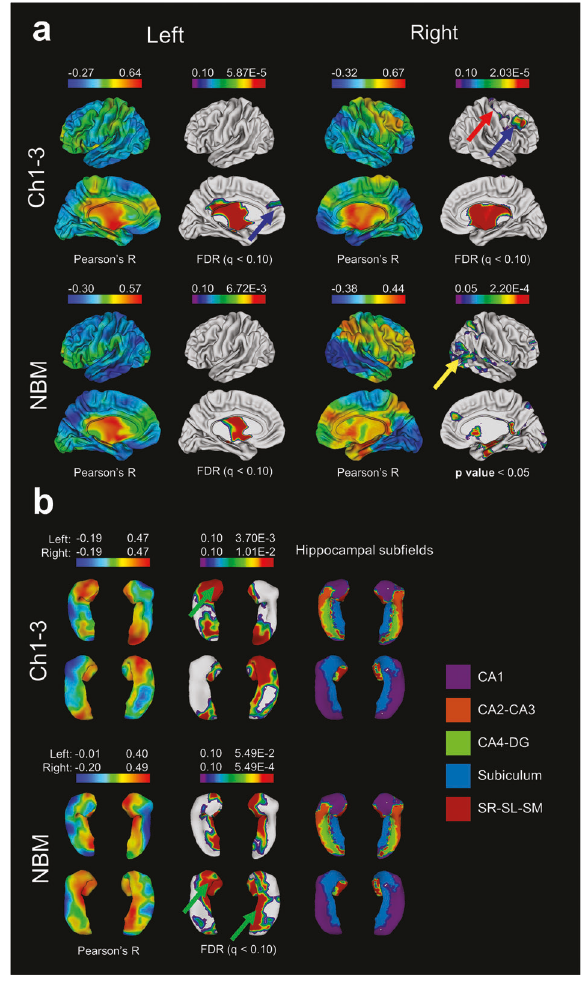
Fig. 3 NBM-cortical and NBM-hippocampal qT1 correlations. Warm colours (red) indicate most positive correlations, and cool colours (blue) negative correlations for each set of surfaces. Regions surviving FDR correction are displayed, while for the right NBM- cortical correlations no regions survived FDR correction at q < 0.10, and thus subthreshold fi ndings at p < 0.05 are shown instead. a NBM-cortical qT1 correlations. Findings are consistent with the hypothesis with strongest (most positive) correlations re fl ecting cortical regions receiving the most consistent afferent projections the BF, and those regions with cortical cholinergic neurons. These include the frontal (blue arrow), sensory/motor cortices (yellow arrow). b NBM-hippocampal qT1 correlations — for the hippocam- pus, CA1-subiculum demonstrate strongest correlations (green cortical surfaces show signi fi cant correlations, re fl ecting the medial pathway of Ch4 projections [72]. After FDR correction, we observed signi fi cant correlations for frontal (Fig. 3a, blue arrow), precentral/postcentral (red arrow). BF-hippocampal corre- lations show the CA1 and subiculum as the most prominent regions (Fig. 3b, green arrows).